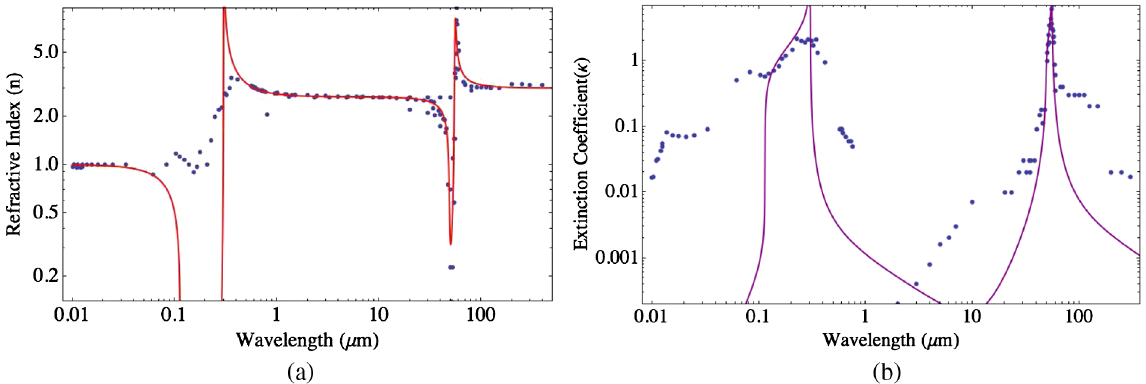
FIG. 3. Comparison between experiment data and fits for the refractive index (a) and extinction coefficient (b) for ZnTe. The experimental data was extracted from Ref.